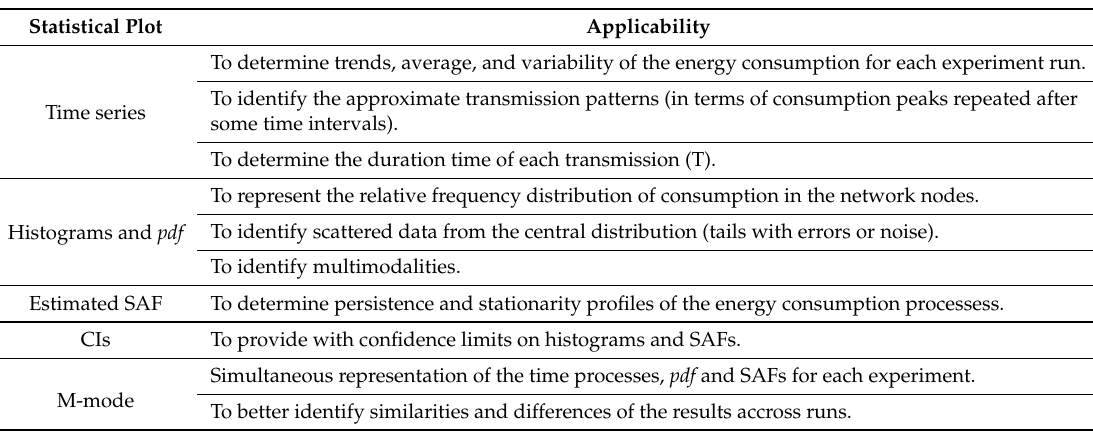
Table A1. Summary of statistical tools used for consumption dynamics